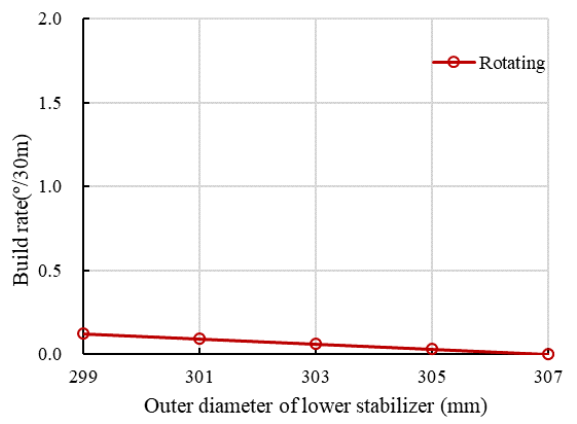
Fig. 26. Sliding build rate VS WOB